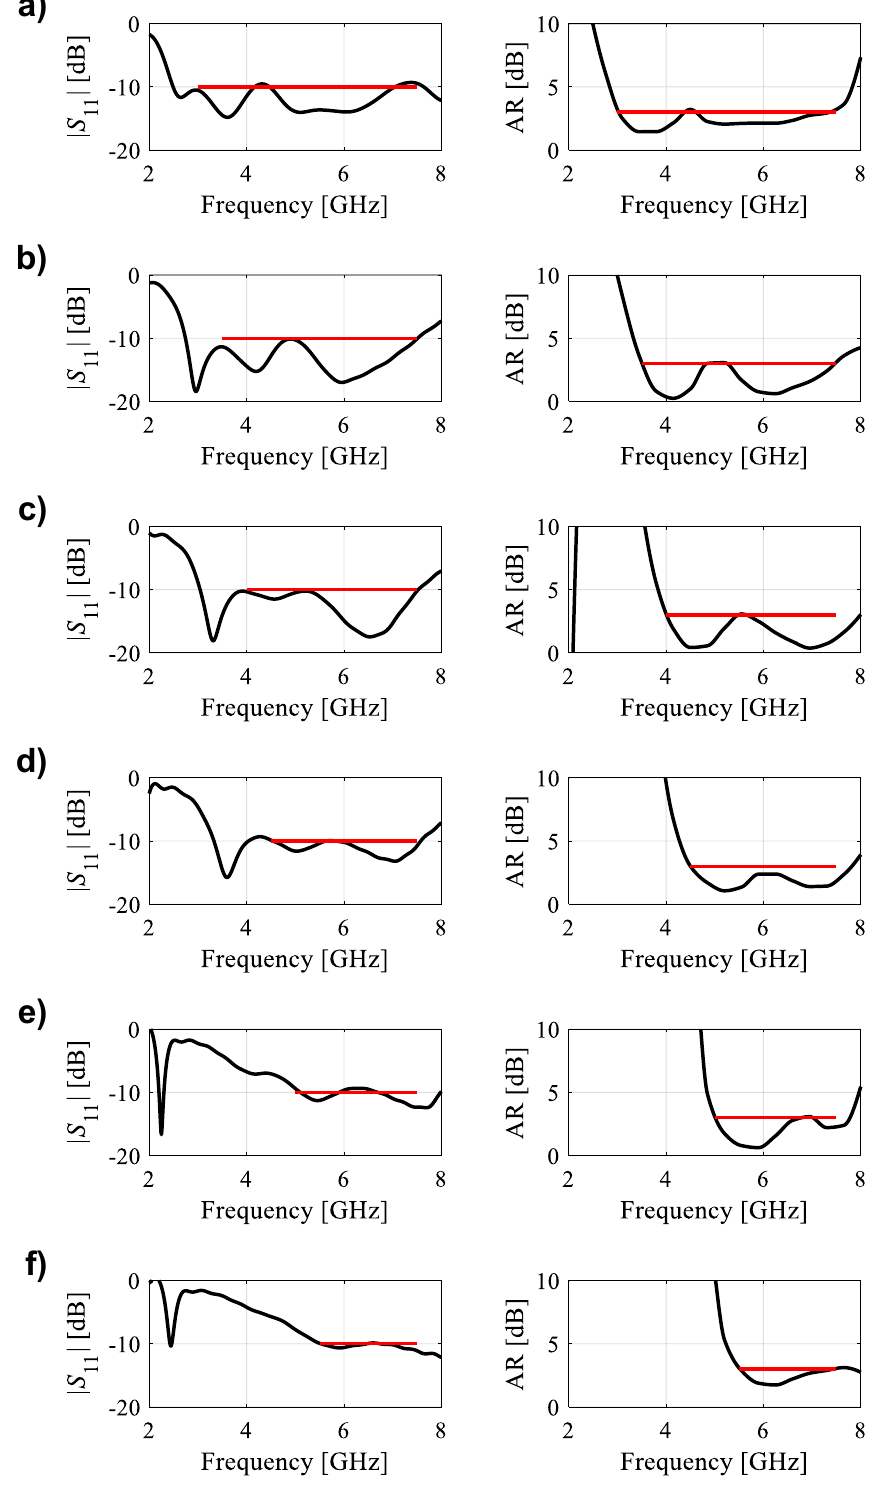
Figure 10. Trade-off designs for the CP antenna of Fig. 7: reflection (left) and axial ratio (right) responses. Horizontal lines represent the target operating bandwidth: ( a ) f L = 3.0 GHz, ( b ) f L = 3.5 GHz, ( c ) f L = 4.0 GHz, ( d ) f L = 4.5 GHz, ( e ) f L = 5.0 GHz, ( f ) f L = 5.5